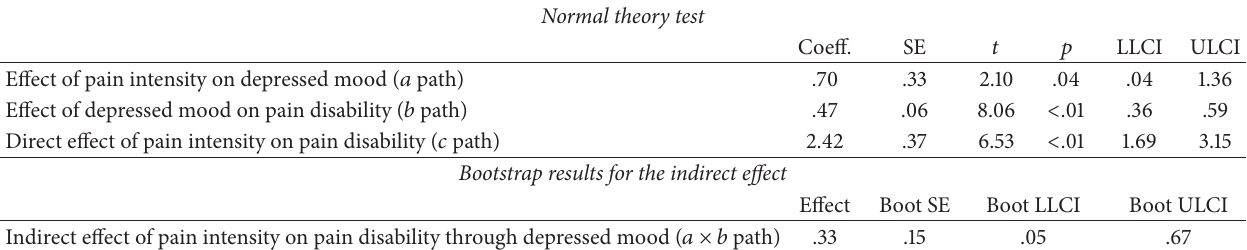
Table 3: Results of the simple mediation analysis investigating depressed mood as a mediator between pain intensity and pain disability. Normal theory